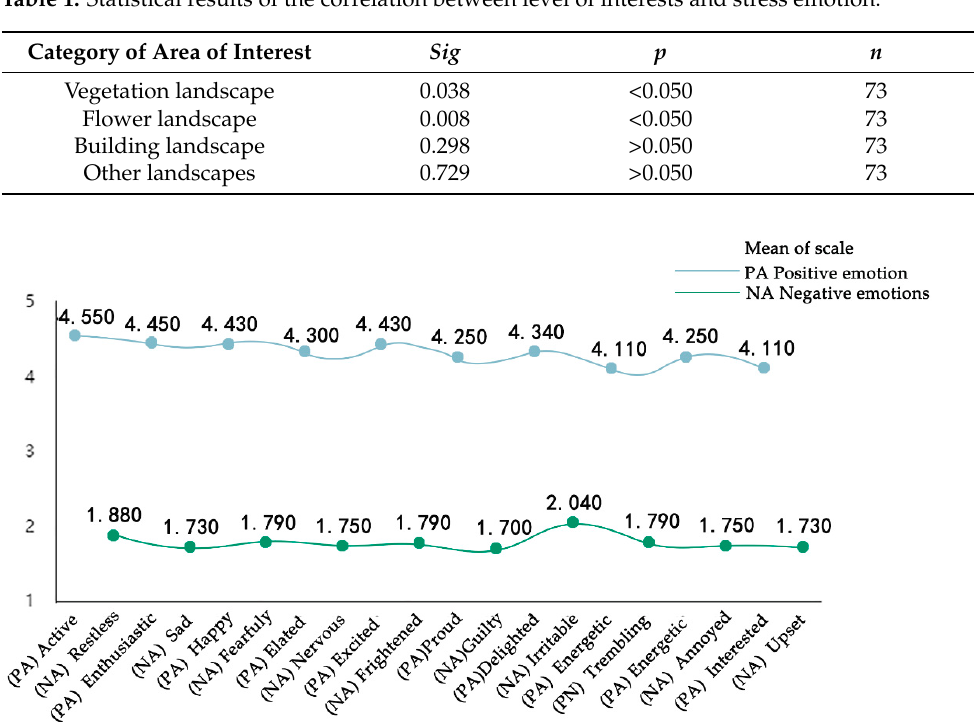
Figure 8. Trend of positive and negative emotion scales.